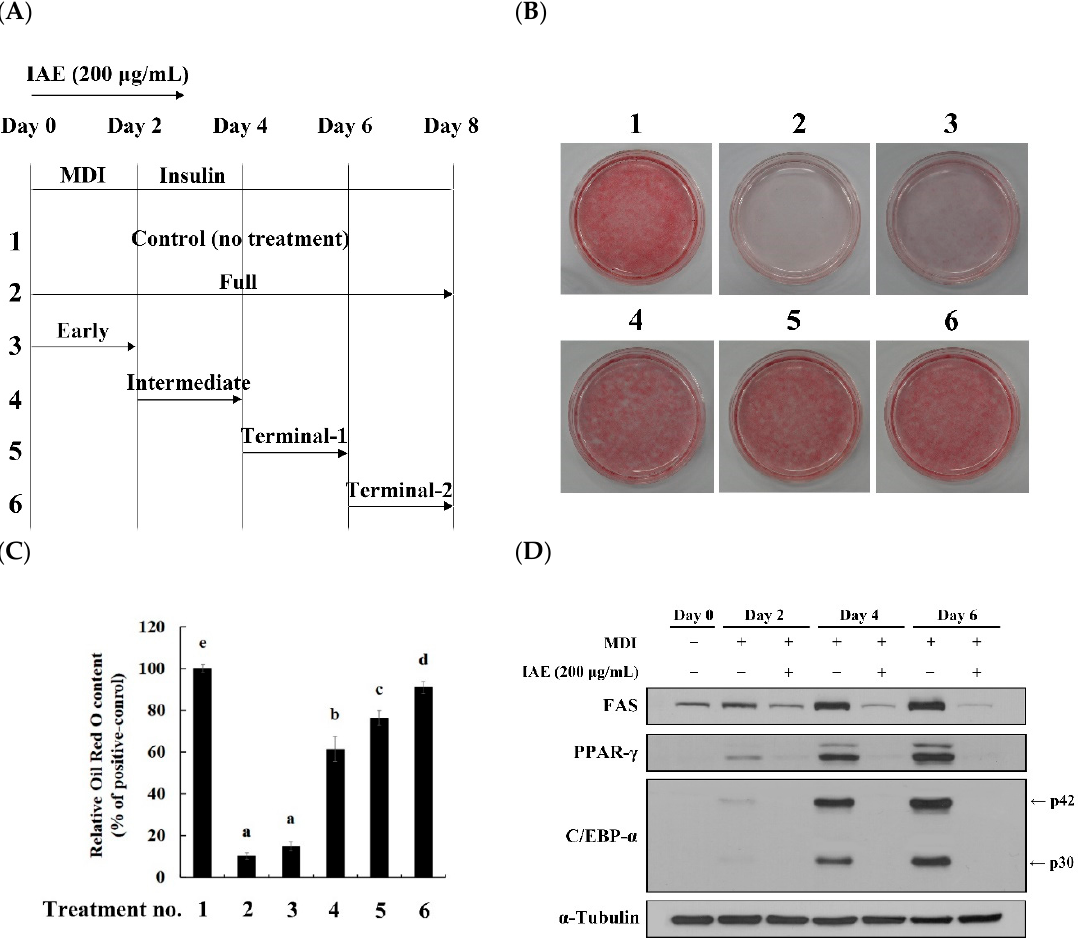
Figure 3. Inula britannica flower aqueous extract (IAE) affects the early phases of adipogenesis. During the eight days of 3T3-L1 differentiation, IAE (200 μ g/mL) was treated at different time points as indicated. ( A ) Schematic depiction of different treatment intervals of IAE during 3T3-L1 differentiation. ( B ) Intracellular lipids were stained with Oil Red O on day 8. ( C ) Relative absorbance of Oil Red O dye eluted from intracellular lipids at 500 nm. ( D ) Expression levels of adipogenesis-associated proteins on day 0, 2, 4, and 6 of differentiation. The data are presented as mean ± standard deviation. Values labeled with different letters are significantly different ( p < 0.05). Differences among the multiple groups were determined based on one-tailed one-way analysis of variance, followed by Tukey's post hoc test.